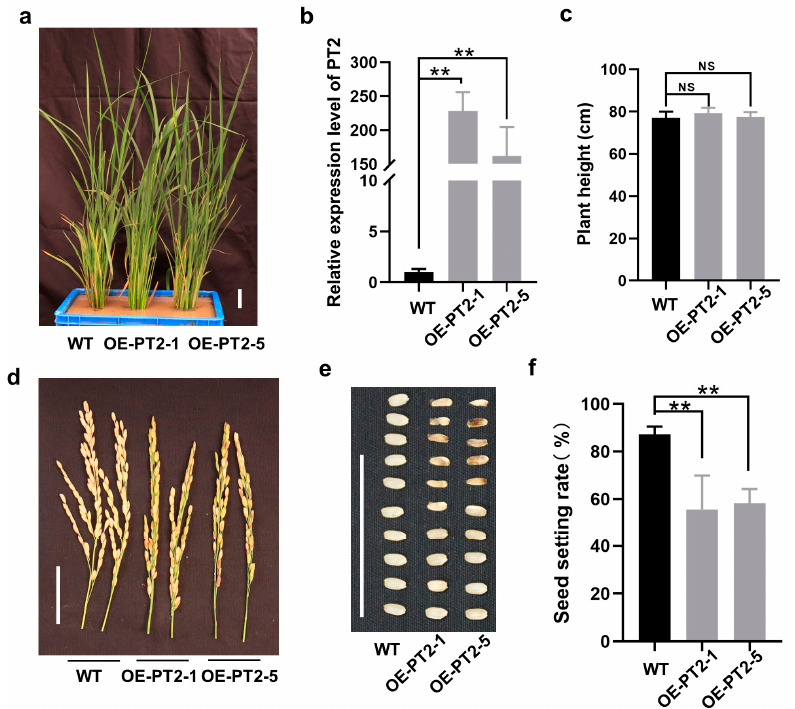
Figure 6. Overexpression of PT2 in rice: ( a ) Two lines of plants expressing the PT2 gene (OE-PT2-1 and OE-PT2-5). ( b ) Results of qRT-PCR showing the relative expression levels of PT2 in plants (** p < 0.01). ( c ) Plant height of OE-PT2-1 and OE-PT2-5 plants (NS: no significance). ( d , e ) Panicles ( d ) and seeds ( e ) of WT plants and OE-PT2-1 and OE-PT2-5 plants. ( f ) Seed setting rate of WT plants and OE-PT2-1 and OE-PT2-5 plants (** p < 0.01). Bars, 4 cm. Values are means ± SD. Student’s t test was used to test the significance of the difference.